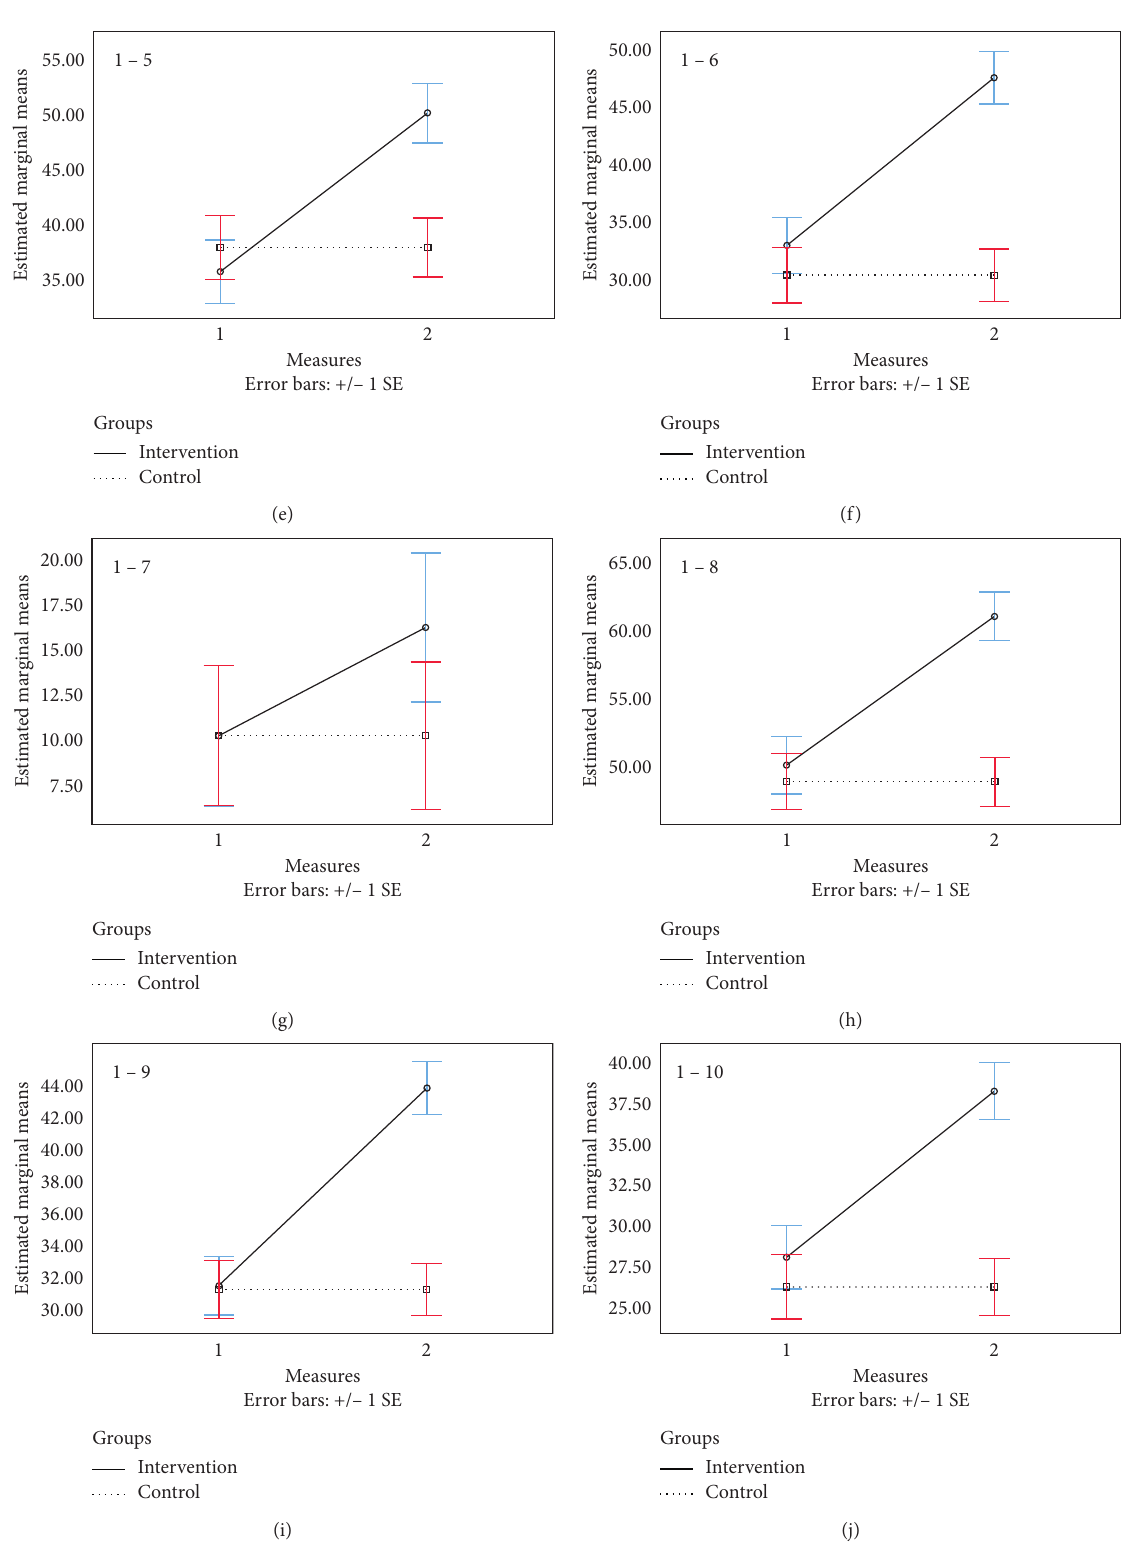
Figure 2: Interaction of time–group for measurements: (a) 1-1, physical function, (b) 1-2, role physical, (c) 1–3, body pain, (d) 1–4, general health, (e) 1–5, vitality, (f) 1–6, social functioning, (g) 1–7, role emotional, (h) 1–8, mental health, (i) 1–9, total physical health, and (j) 1–10, total mental